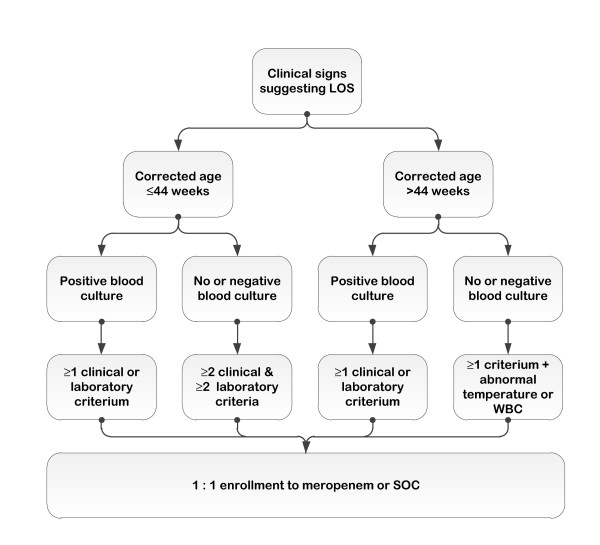
Flowchart of the NeoMero1 study.